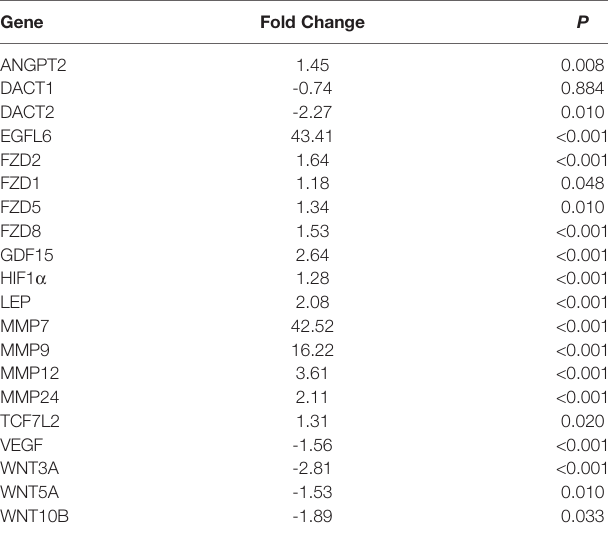
TABLE 4 | Fold change of genes involved in expansion (hypertrophy and hyperplasia) and remodelling in scWAT in individuals living with obesity at study entry (week